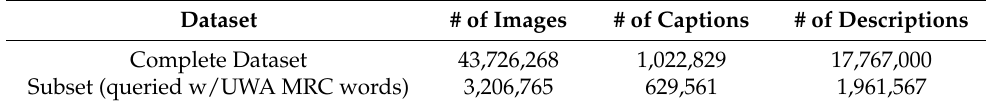
Figure 1. Histogram of the samples retrieved for words. Horizontal axis shows the number of images retrieved, while the vertical axis shows the amount of words which have that many images associated with them. Table 1. Wikimedia Commons dataset